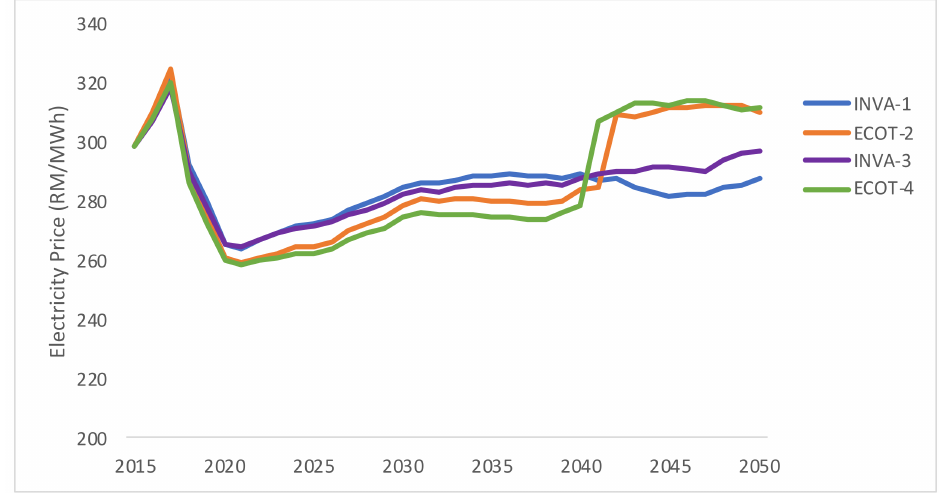
Figure 6. Electricity prices under renewable energy